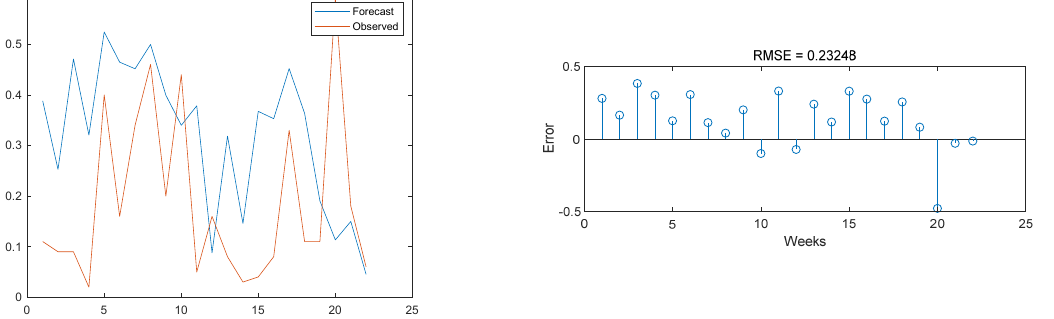
Figure 15. Prediction results of the ANN-LSTM model on the TP test set and comparison with the original image.